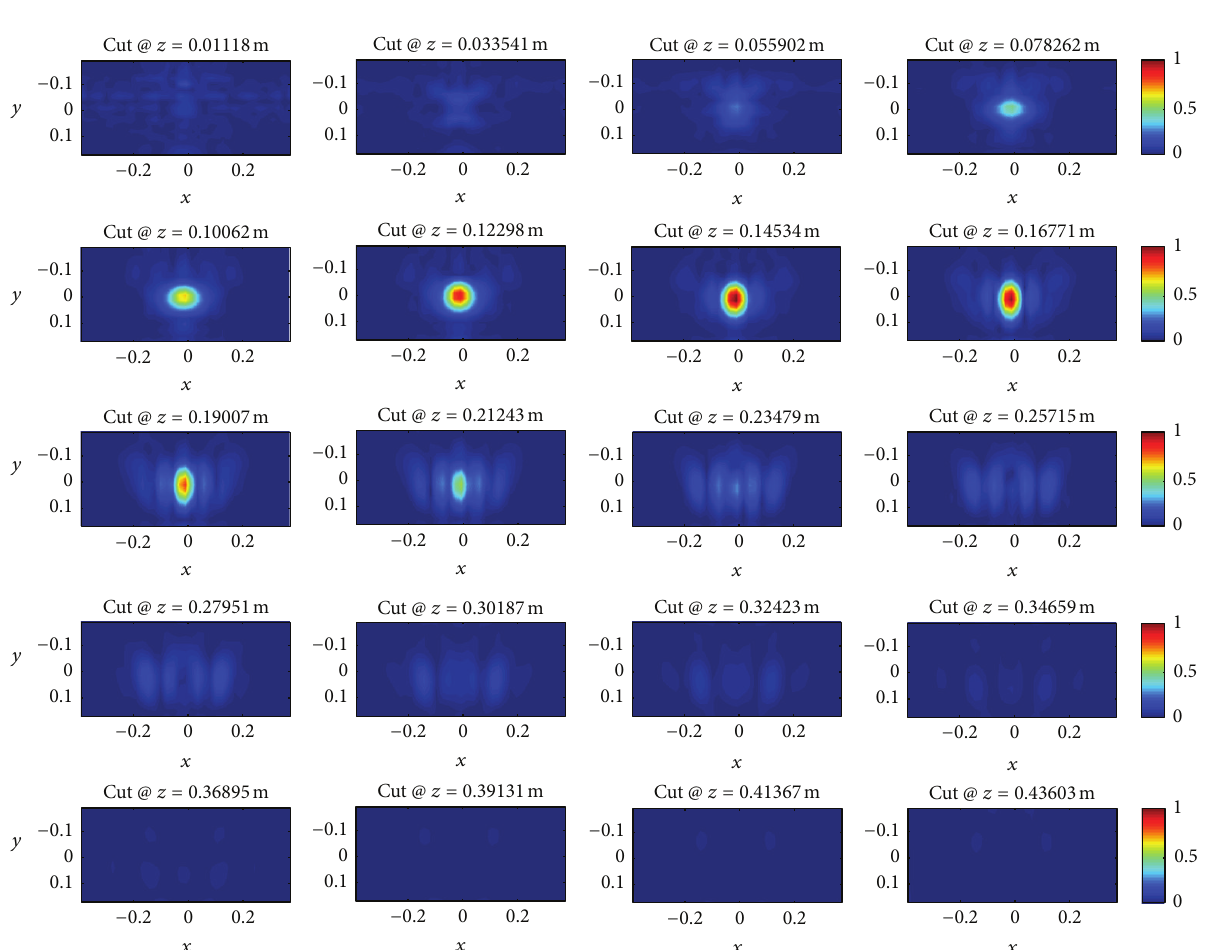
step of 2.24 cm, for an overall investigated height of about 50